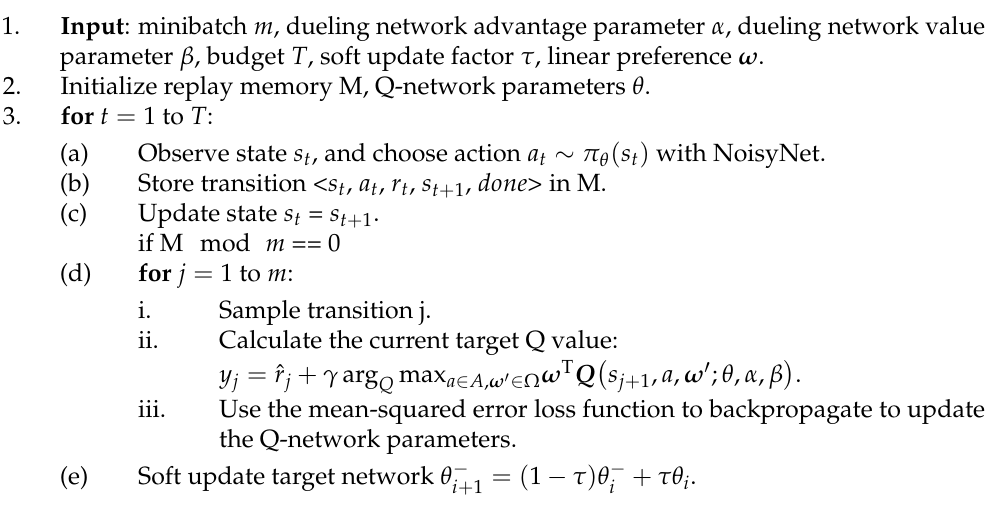
Algorithm 1 Envelope with dueling structure, Noisynet, and soft